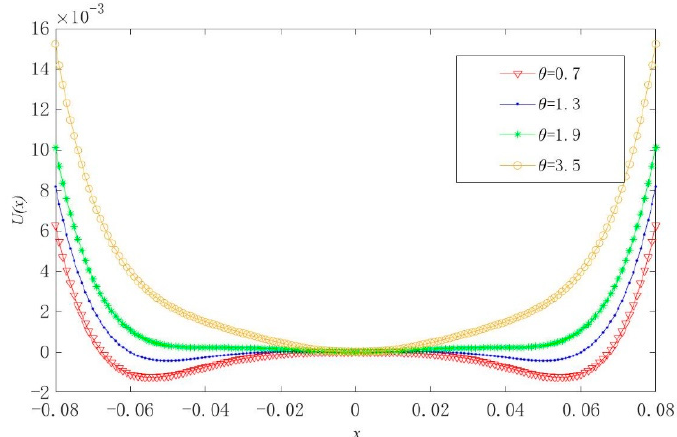
Figure 2. Potential function of the SMA oscillator system (7) for various relative temperatures θ with the system parameters: α = θ − 1, β = − 1.3 × 10 3 , γ = 4.7 × 10 5 .